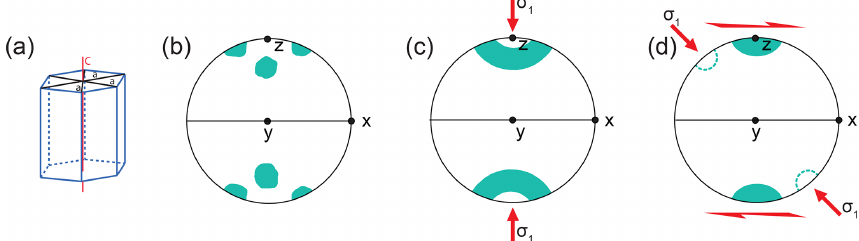
Figure 1. Schematic image showing (a) an ice crystal and its defining c and a axes and (b) a multimaxima fabric pattern identified in warm, coarse-grained glacial ice. The x , y and z axes define the symmetry, but the kinematics are debated. (c) A small circle girdle or cone shape under uniaxial compression and (d) a strong single maximum fabric plus or minus a weaker second maximum in simple shear. Panels (c) and (d) are from experiments, and (c) (arguably) and (d) are also from nature, and the axes x , y and z define the kinematic reference frame. CPO plots here and in subsequent figures are all equal-area, lower-hemisphere projections. In (b) and (d) , z is normal to the foliation and x is parallel to the shear direction. There is no shear plane implied in (c) .